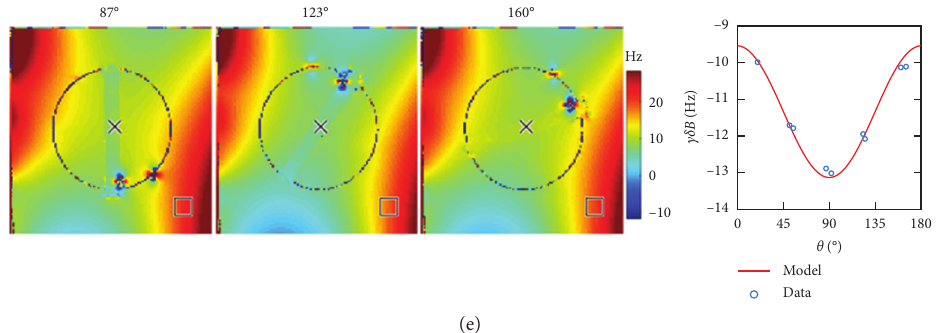
Figure 4: Each row in this figure shows five different examples of sequence (at 1mm resolution, TR � 45ms) and phase estimation method pairs for three different angles of rotation in different tubes. These examples were selected to illustrate the spatial nature of different phase estimations errors and artifacts. The corresponding plots in the last column show the resulting frequency measurements as a function of angle of rotation (modulo 180 ° ), for a voxel inside the tube, after frequency referencing (blue circle). The predicted frequency offset as obtained from equation (1) is also shown in solid red line. The background ROI (#9) used is shown with a square overlaid on the frequency maps. (a) SEGE+GBC shows a phase wrapping error in tube 3 in the frequency reference ROI for the 160-degree angle. (b) SEGE+Laplace shows smoothly varying frequency maps; however, the values deviate from the expected result at every angle. (c) MEGE+Slope, without 3D phase unwrapping, shows the presence of phase wrapping in areas with large frequency values. The frequency reference ROI is within a phase wrapped region across all angles. (d, e) MEGE+MAGPI-unopt and MAGPI’s phase estimation show frequency maps consistent with values predicted from the